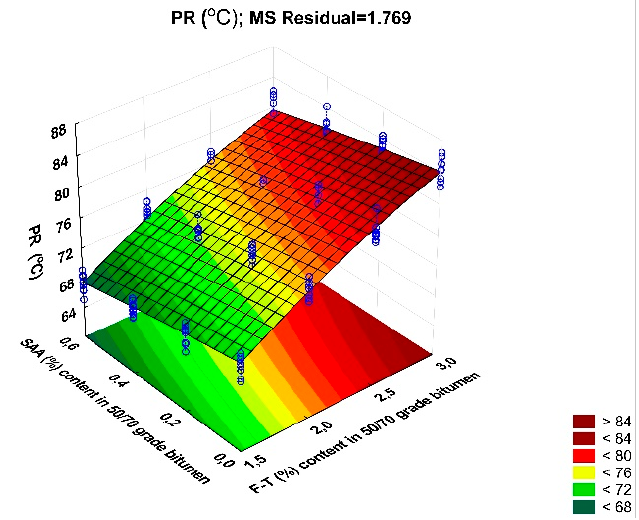
Figure 13. Response surface plot for plasticity range of bitumen 50/70 and its model.